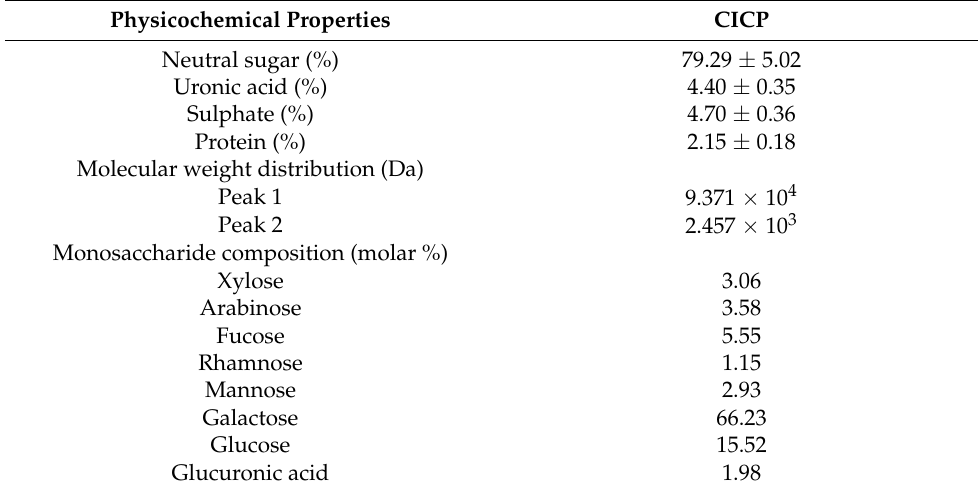
Table 1. Preliminary characteristics of CICP